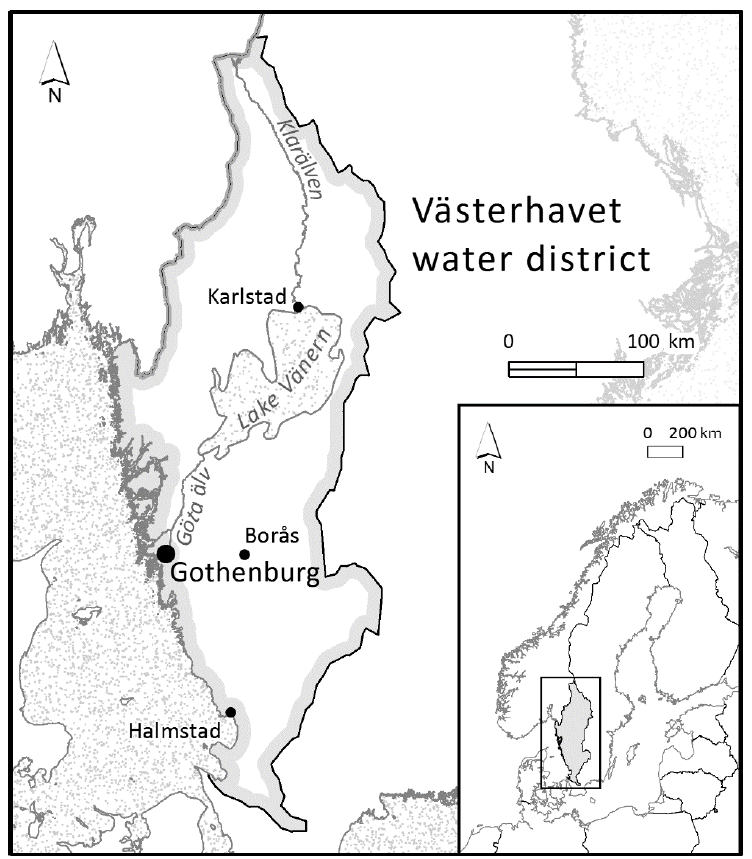
Figure 1. The Västerhavet Water District (revised from Västerhavet Water Authority 2011, GIS graphics courtesy of Magnus